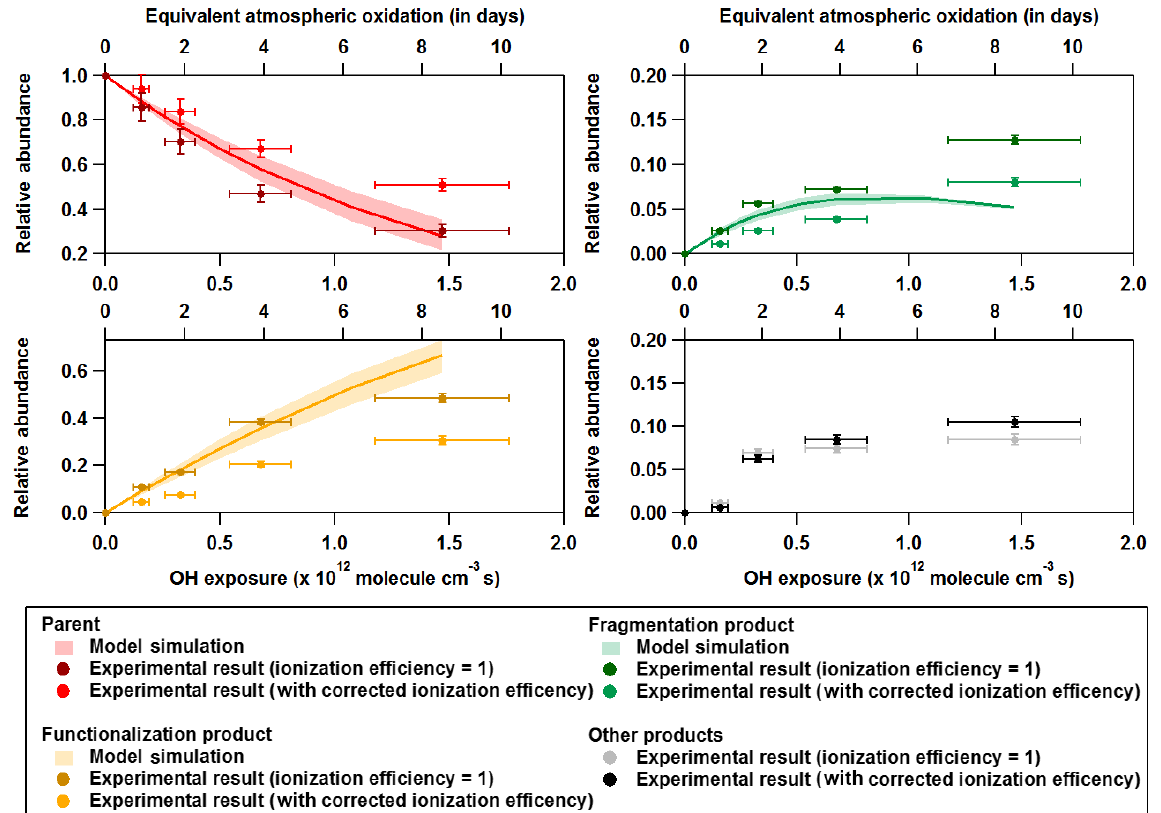
Figure 3. Evolution of the parent (C 5 H 8 O 4 ), major functionalization (C 5 H 8 O 5 ), and major fragmentation (C 4 H 6 O 3 ) products during het- erogeneous OH oxidation of the aqueous methylsuccinic acid droplet. Experimental values are shown in markers with 1 SD as uncertainty. The shaded region shows the error of the effective OH uptake coefficient ( γ eff ) measurement in the model